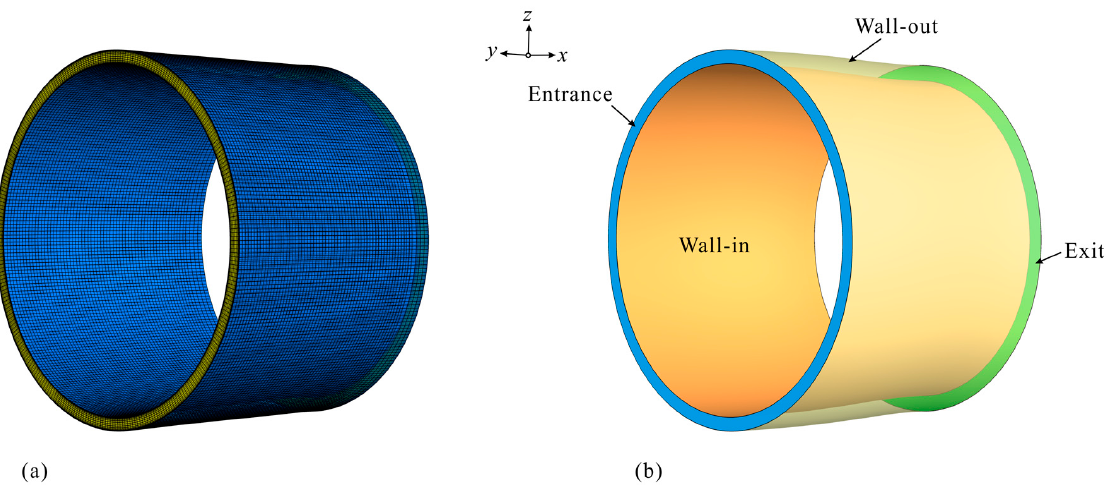
Figure 2. Surface grid and boundary conditions. ( a ) Surface grid. ( b ) Computational domain and boundary conditions. Table 2. Incoming flow conditions at the entrance.